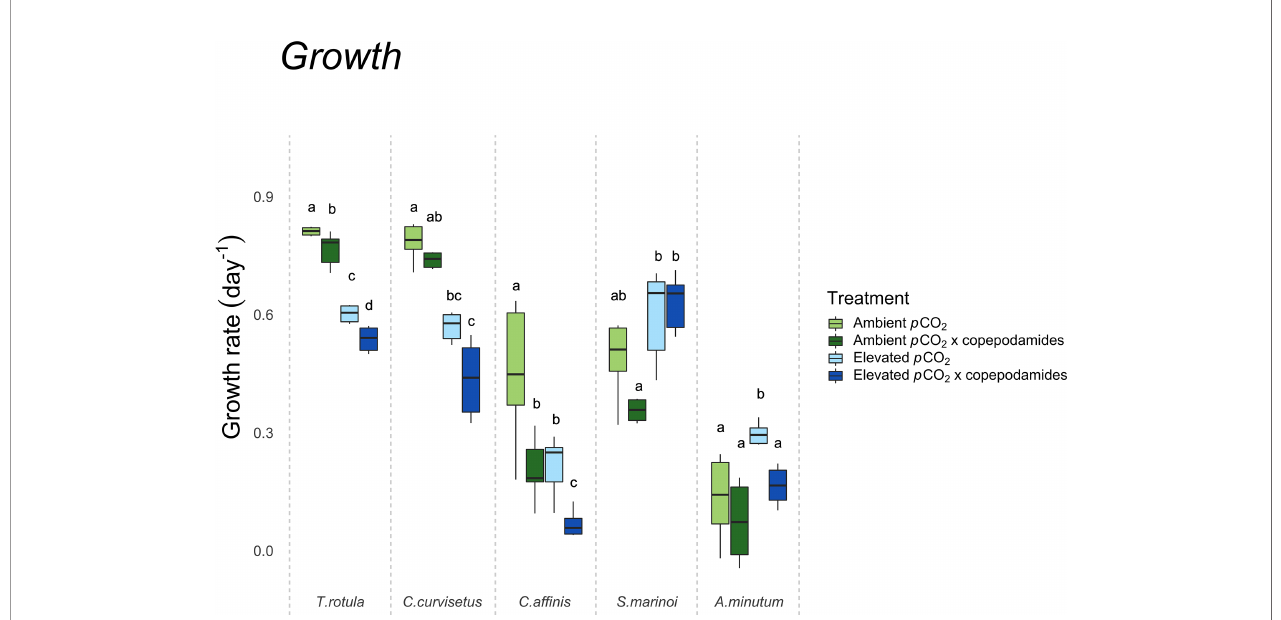
FIGURE 1 | Box plot showing the speci fi c growth rates (day − 1 ) for T. rotula, C. curvisetus, C. af fi nis, S. marinoi and A. minutum after 48 hours of exposure to one of four treatments ( “ ambient p